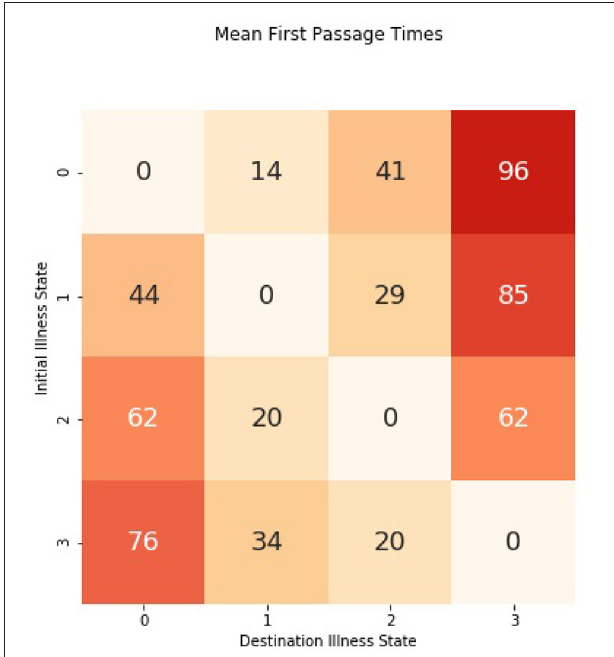
FIGURE 5 | Mean first passage times from initial illness states to destination illness states. For each possible initial illness state, denoted by rows, the amount of time (in hours) required to reach the destination illness state in shown. The 0 s along the diagonal indicate that the number of steps to reach the same state were not